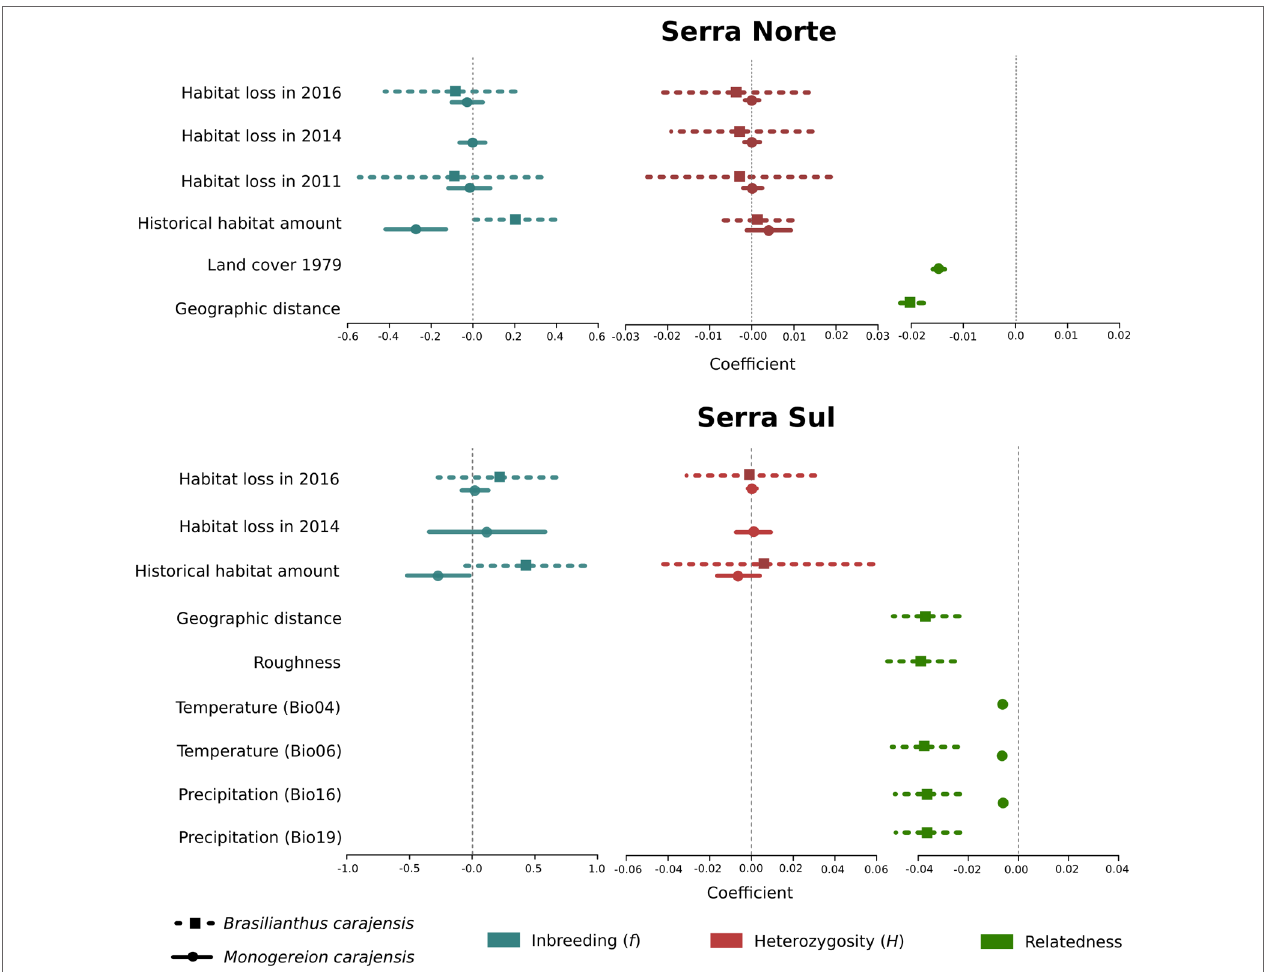
FiGURE 4 | Coefficient plots for the set of best-fitting models (ΔAIC ≤ 2) for Brasilianthus carajensis and Monogereion carajensis in Serra Norte and Serra Sul (see Materials and Methods and Supplementary Tables S4 and S6 for details). Points represent model-averaged regression coefficients and lines the 95% confidence